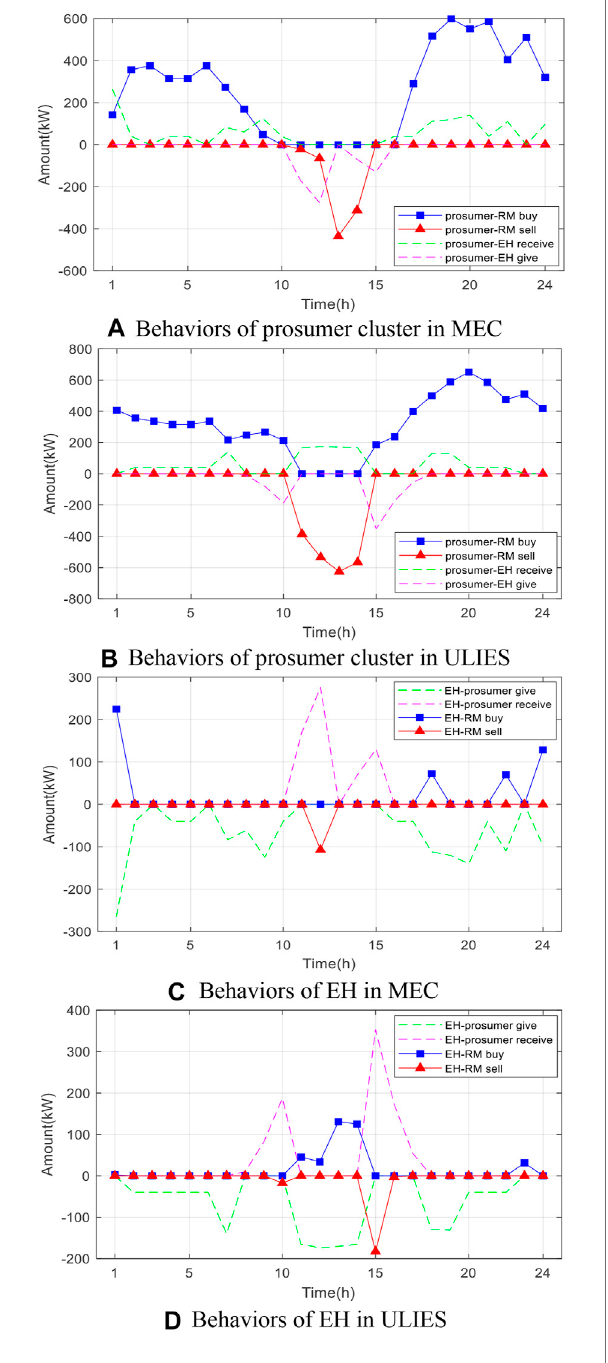
FIGURE 5 | Behaviors of prosumer cluster and EH. (A) Behaviors of prosumer cluster in MEC, (B) behaviors of prosumer cluster in ULIES, (C) behaviors of EH in MEC, and (D) behaviors of EH in ULIES.